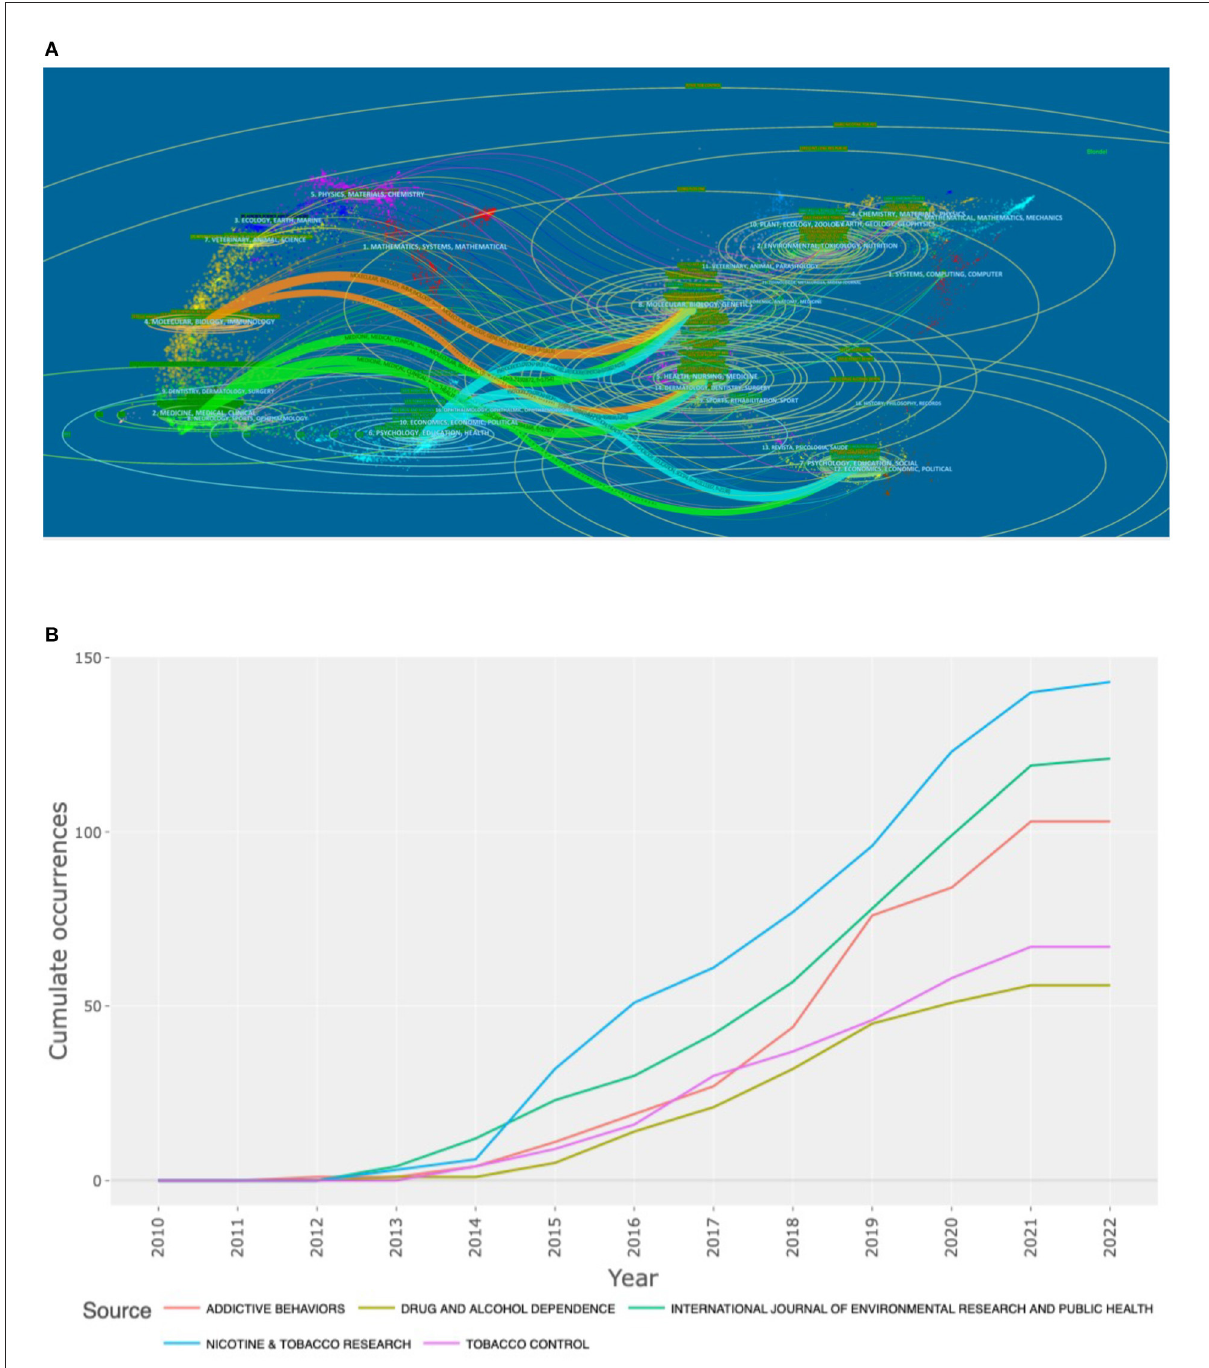
FIGURE4 Visualization of Core Journals. (A) Souce dynamics of top 5 Core Journals. (B) Biplot overlay of article citations for electronic cigarette